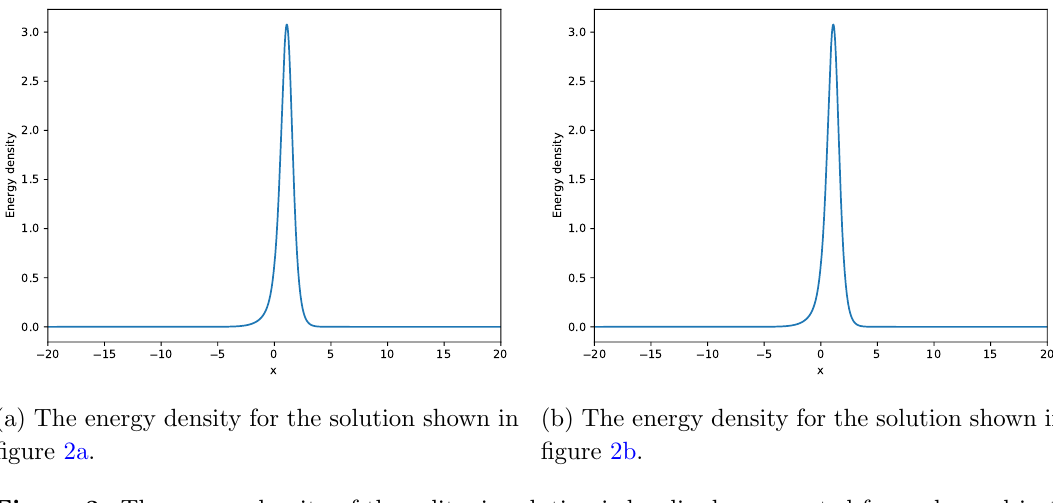
Figure 3. The energy density of the solitonic solution is localised as expected for such an